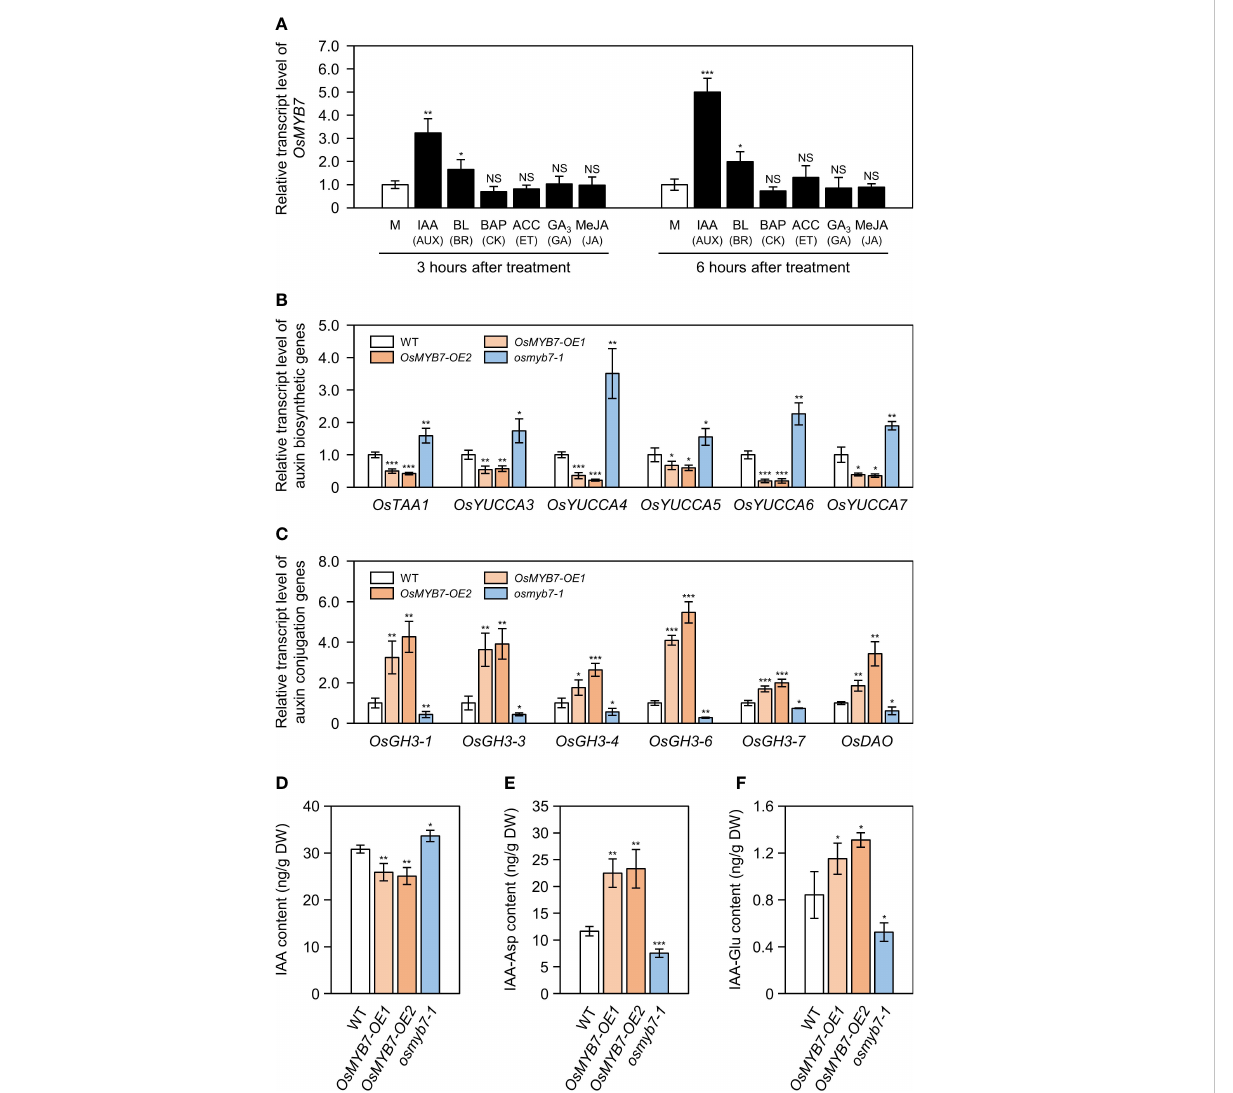
FIGURE 6 Alteration in free auxin levels at lamina joints may be one cause of different leaf angle phenotypes among WT, OsMYB7-OE1 , OsMYB7-OE2 , and osmyb7-1 . (A) Relative OsMYB7 expression levels in response to various phytohormones determining leaf angle. WT seedlings were grown on half- strength solid MS medium for ten days under constant light conditions at 28°C, followed by incubation in half-strength liquid MS medium containing with 100 m M IAA, 10 m M BL, 10 m M BAP, 10 mM ACC, 100 m M GA 3 , or 100 m M MeJA. WT seedlings incubated in half-strength liquid MS medium without phytohormone were used as a mock. Total RNA was extracted from shoots collected after 3 or 6 h of treatment, and used for RT-qPCR analysis. The transcript levels of OsMYB7 were normalized to those of GAPDH , with the expression level in the phytohormone-treated group shown relative to that in the mock-treated group, which was set to 1. Data are presented as means ± SD from four biological samples (around 3 shoots per sample). Asterisks indicate signi fi cant differences compared to the mock-treated sample, as determined by two-tailed Student ’ s t -test (* P < 0.05, ** P < 0.01, and *** P < 0.001). This experiment was performed independently twice and similar results were obtained. AUX, auxin; BR, brassinosteroid; CK, cytokinin; ET, ethylene; GA, gibberellin; JA, jasmonic acid; M, mock; NS, not signi fi cant. (B, C) Relative expression of auxin biosynthetic (B) and conjugation (C) genes at the lamina joint. The cDNA samples in Figure 4A were subjected to RT-qPCR analysis. GAPDH was used as an internal control and the relative expression of each gene is shown relative to that in WT (set to 1). Data are presented as means ± SD of four biological replicates. Asterisks indicate signi fi cant differences as determined by two-tailed Student ’ s t -test (* P < 0.05, ** P < 0.01, and *** P < 0.001). These experiments were conducted twice yielding similar results. (D – F) Contents for free IAA and IAA-amino acid conjugates (IAA-Asp and IAA-Glu). Flag leaf lamina joints at the S5 developmental stage in WT, OsMYB7-OE1 , OsMYB7-OE2 , and osmyb7-1 plants were collected and subjected to LC-ESI- MS/MS analysis for quanti fi cation of free IAA (D) , IAA-Asp (E) , and IAA-Glu (F) . Data are presented as means ± SD from four biological replicates (around 10 lamina joints per plant and around 15 plants per replicates). Asterisks indicate signi fi cant differences as determined by two-tailed Student ’ s t -test (* P < 0.05, ** P < 0.01, and *** P < 0.001). DW, dry weight; IAA, indole-3-acetic acid; IAA-Asp, IAA-aspartate; IAA-Glu,